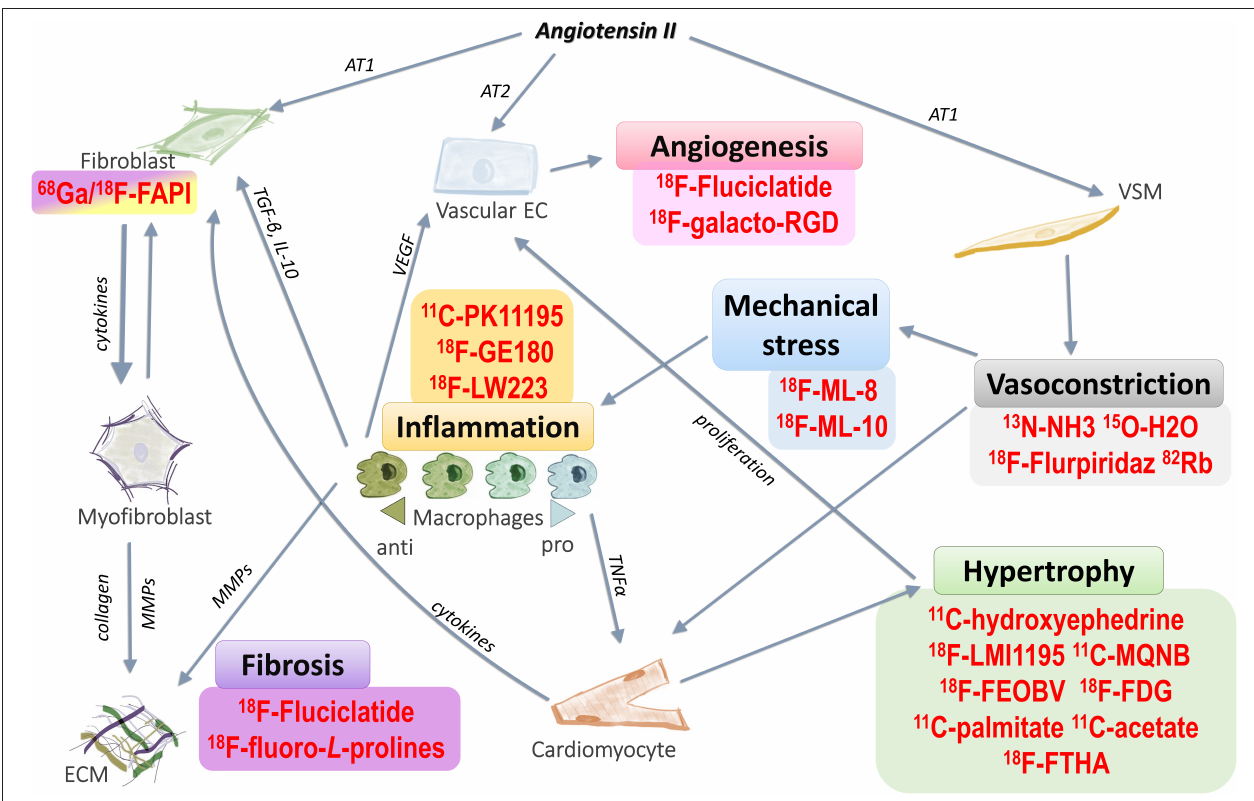
FIGURE 1 | Targeting pathways related to hypertensive heart failure with PET radiotracers. Angiotensin II stimulates a number of different pathways that contribute to cardiac remodeling in hypertensive heart failure. These pathways can be targeted with various PET radiotracers, which can then assess processes related to, but not limited to, hypertrophy, vasoconstriction, mechanical stress, inflammation, fibrosis and angiogenesis. Examples of these radiotracers are shown above. Angiotensin II acting through the AT1 receptor on vascular smooth muscle it can induce vasoconstriction, leading to mechanical stress on the cardiovascular system. As a result, cardiomyocytes enlarge and the heart hypertrophies. Hypertrophy leads to inadequate blood supply to the affected areas in the heart, inducing the proliferation of vascular endothelial cells to form new blood vessels (angiogenesis), and this is enhanced by proangiogenic signals from anti-inflammatory macrophages. Mechanical stress also causes inflammation in the myocardium, enhancing various pro- and anti-inflammatory signaling pathways, which can lead to cardiac remodeling by promoting fibrosis. Angiotensin II also increases proliferation of fibroblasts via the AT 1 receptor. In contrast, it decreases proliferation of vascular endothelium through activation of the AT 2 receptor. Fibroblasts (as well as macrophages and vascular endothelial cells) may directly differentiate into myofibroblasts. The main activity of myofibroblasts is the generation of collagen deposits in the ECM ( 12–15) AT 1 , angiotensin receptor type 1; AT 2 , angiotensin receptor type 2; VEGF, vascular endothelial growth factor; TGF- β , transforming growth factor beta; IL-10, interleukin 10; TNF- α , tumor necrosis factor alpha; MMPs, matrix metalloproteinases; ECM, extracellular matrix. List of PET radiotracers and their application are presented in more detail in Tables 1 , 2